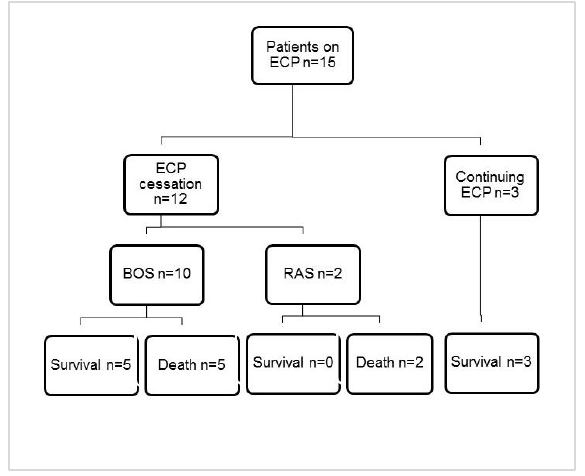
Figure 1: ECP follow-up and survival. On 31 August 2014, 15 patients were undergoing ECP treatment; 12 were stopped between September and December 2014, 3 patients contin- ued and survived the follow-up period. Of the 12 patients stopping ECP, 10 were treated for BOS and 2 for RAS. 5 BOS patients and 2 RAS patients died (death rate 58%). BOS = bronchiolitis obliterans syndrome; ECP = extracorporeal pho- topheresis; RAS = restrictive allograft